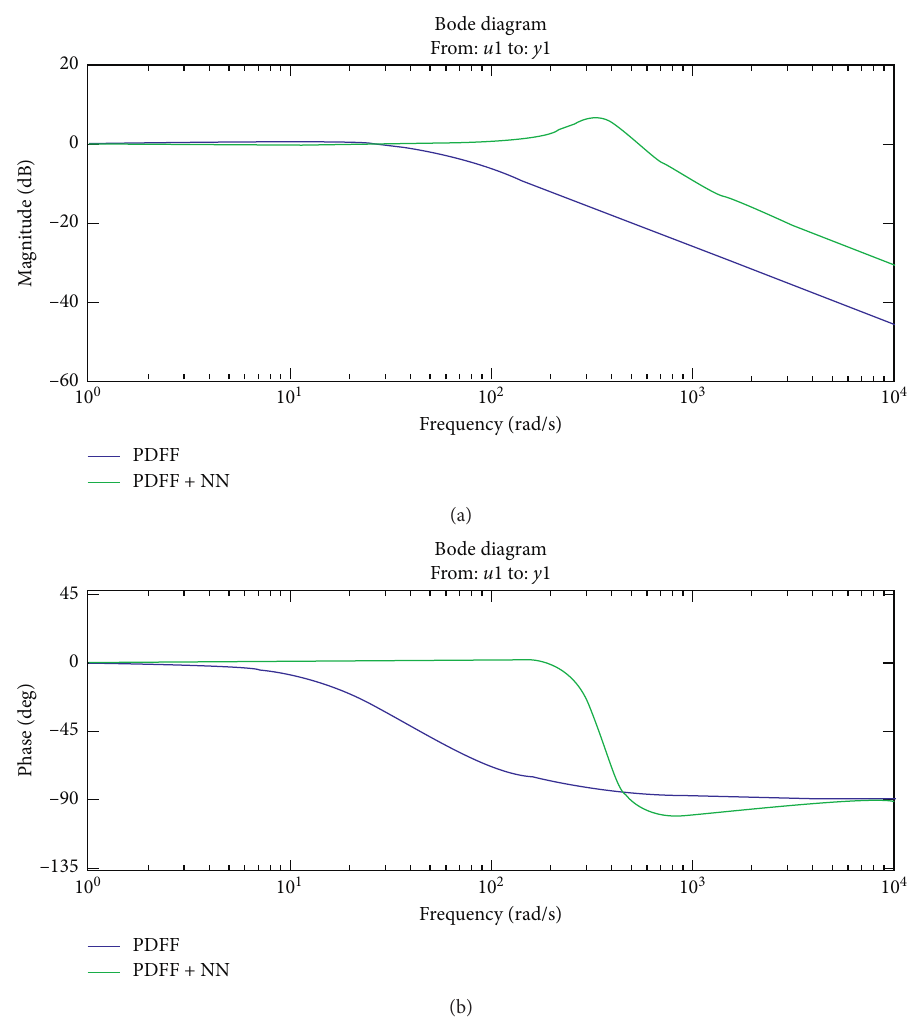
Figure 9: Acceleration frequency characteristics of the shaking table system: (a) magnitude and (b) phase characteristics from reference to measured